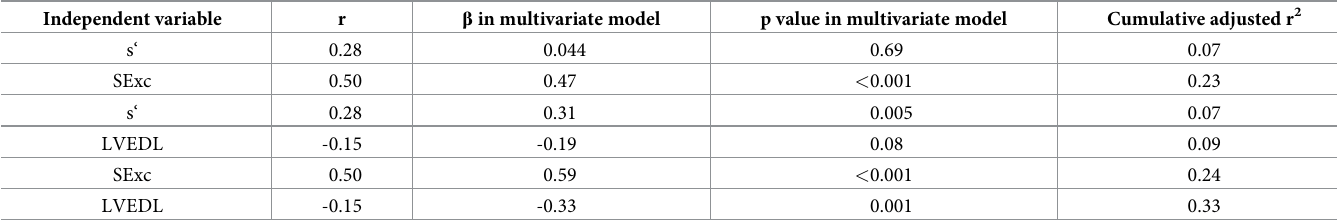
Table 3. Models of the absolute value of GLS including s‘, SExc and LVEDL. Independent